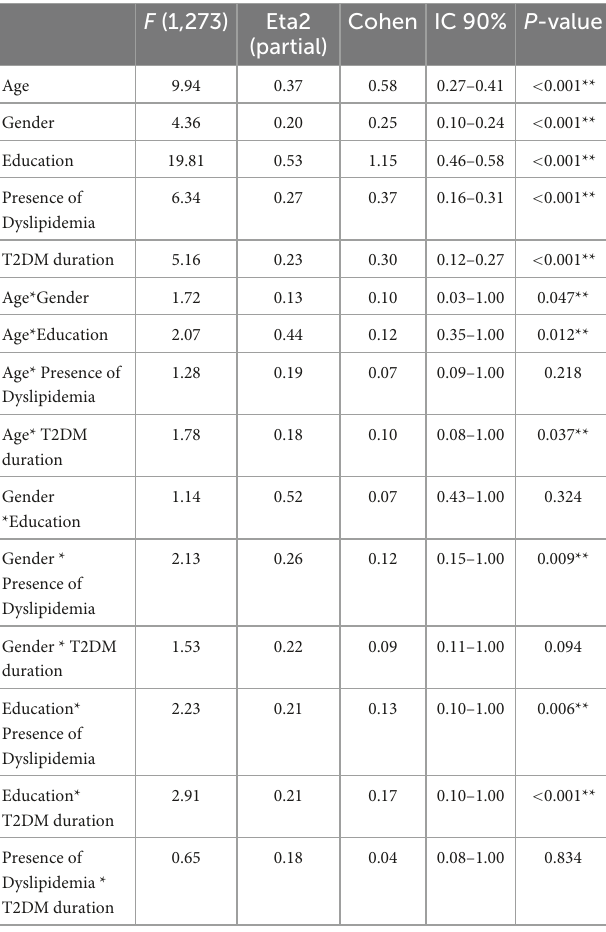
TABLE 7 MANOVA of